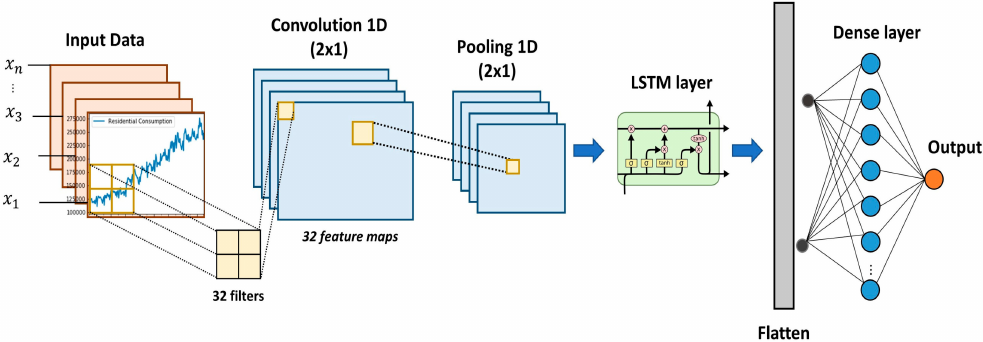
Figure 10. Multivariate CNN-LSTM